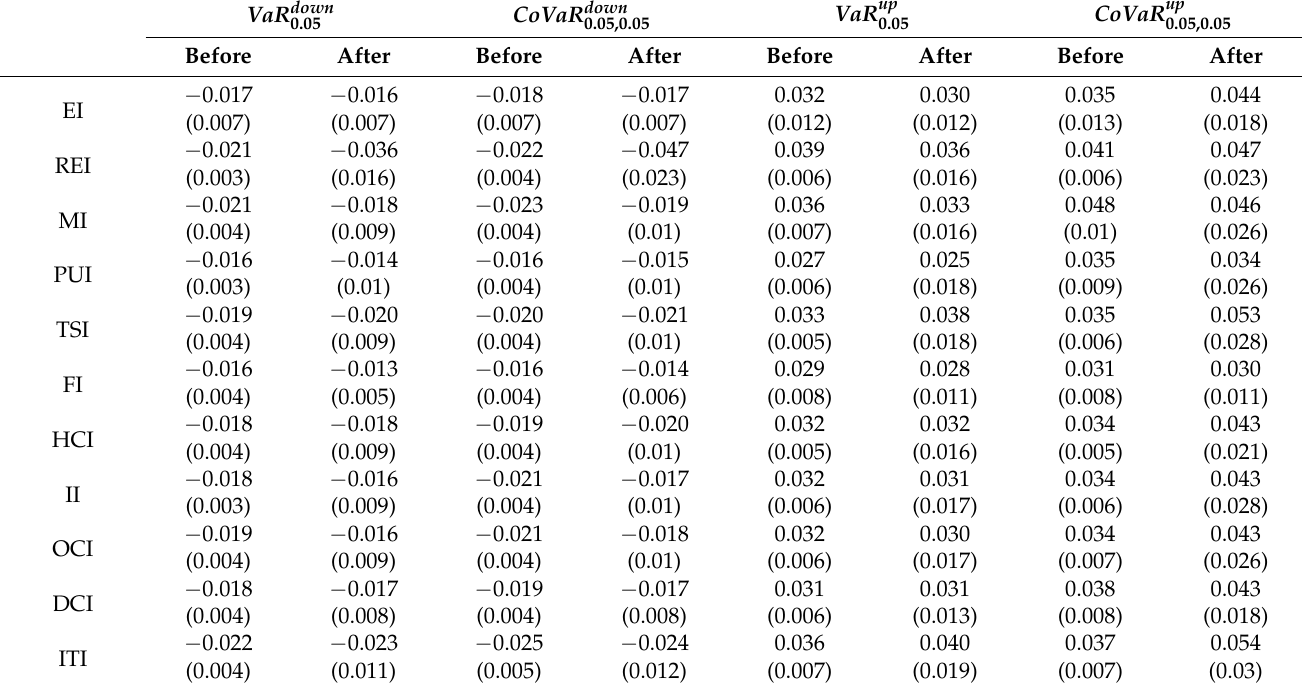
Table 6. Descriptive statistics of tail risk of extreme oil market on Chinese sectoral stock markets. VaR down 0.05